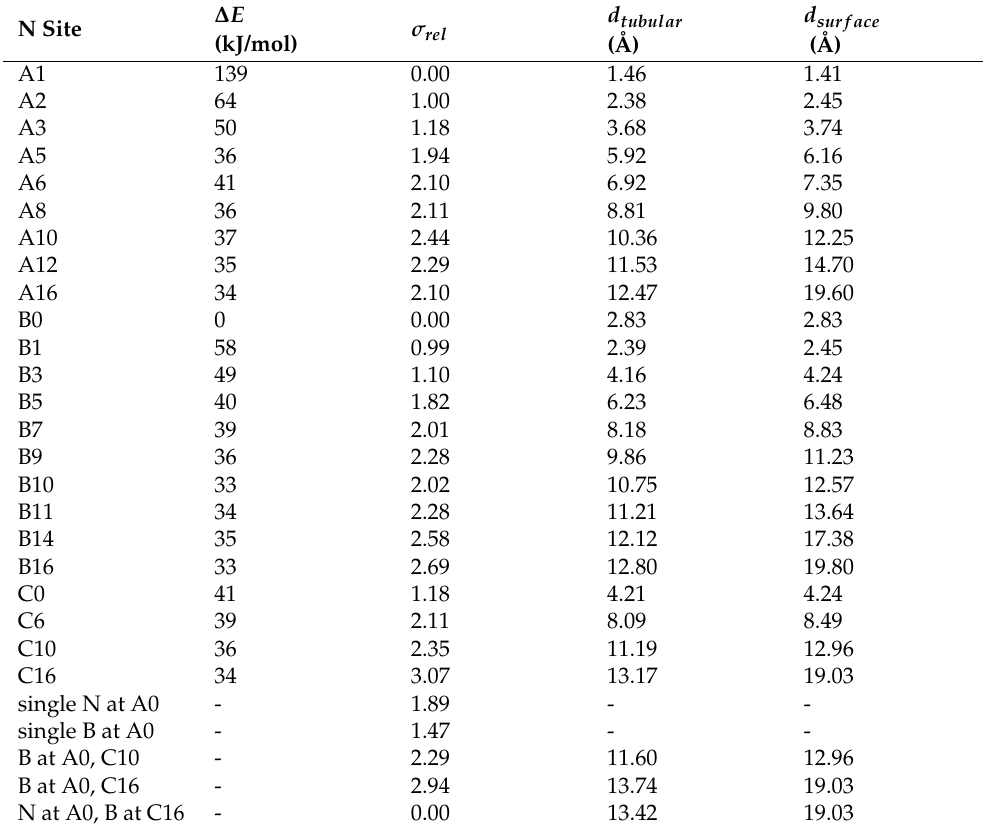
Table 1. Relative energy ( ∆ E ), relative electrical conductivity at Fermi level ( σ rel ), N–N distance across the tube ( d tubular ), and N–N distance on an idealized graphene surface ( d surface ) for the studied systems. Naming scheme is explained in Figure 1. In addition to the N-CNTs with two nitrogen dopants, CNTs with a single N-dopant and a single B-dopant, as well as a B–N-codoped reference system are included in the bottom of the